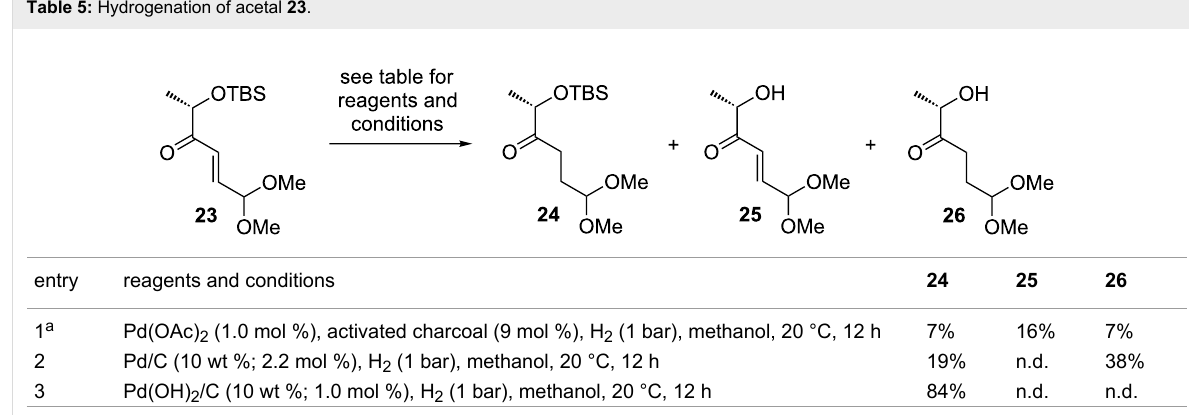
Table 5: Hydrogenation of acetal 23